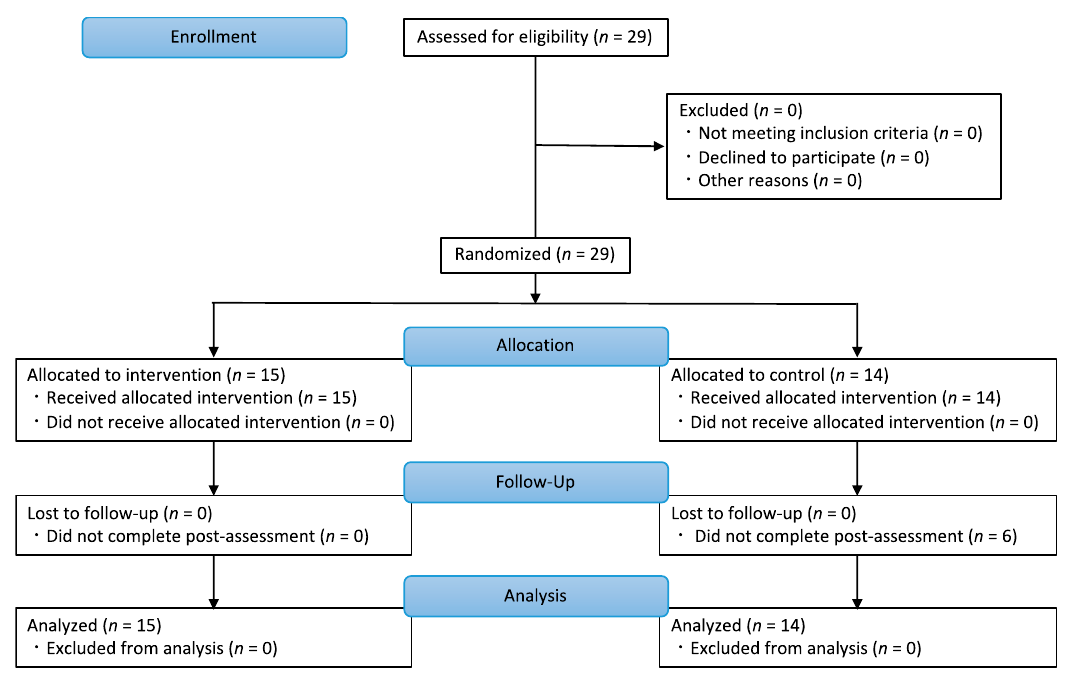
Figure 1. CONSORT flowchart in this study. Twenty-nine participants were randomly assigned to an intervention ( n = 15) or control group ( n = 14).